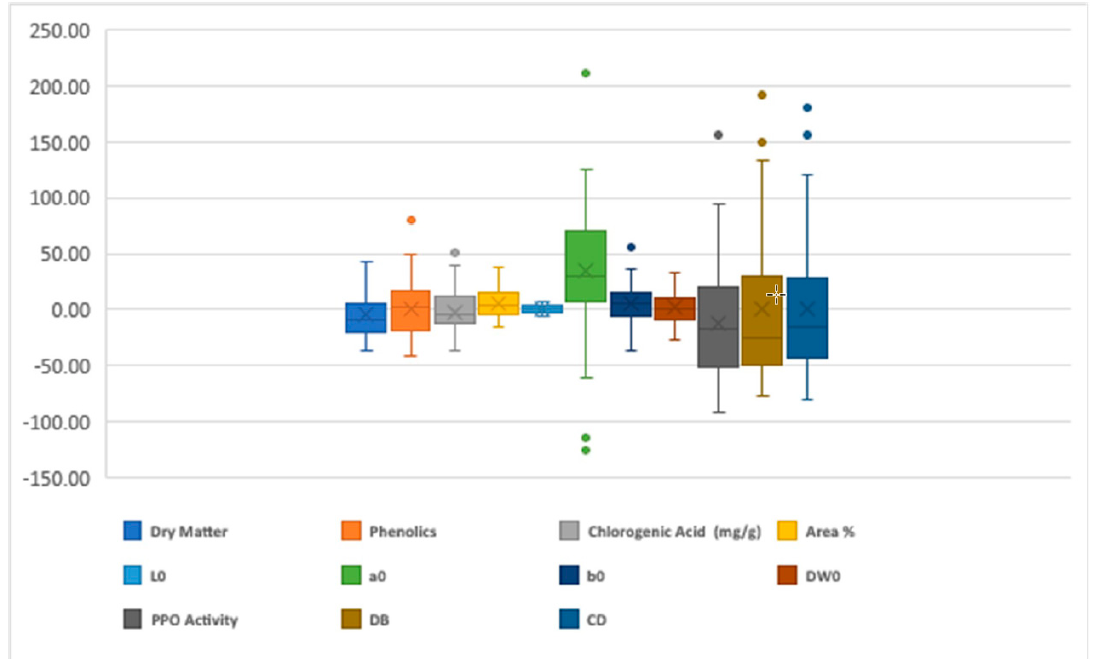
Figure 1. The boxplots (median and interquartile range) representing the mid-parent heterosis (%).